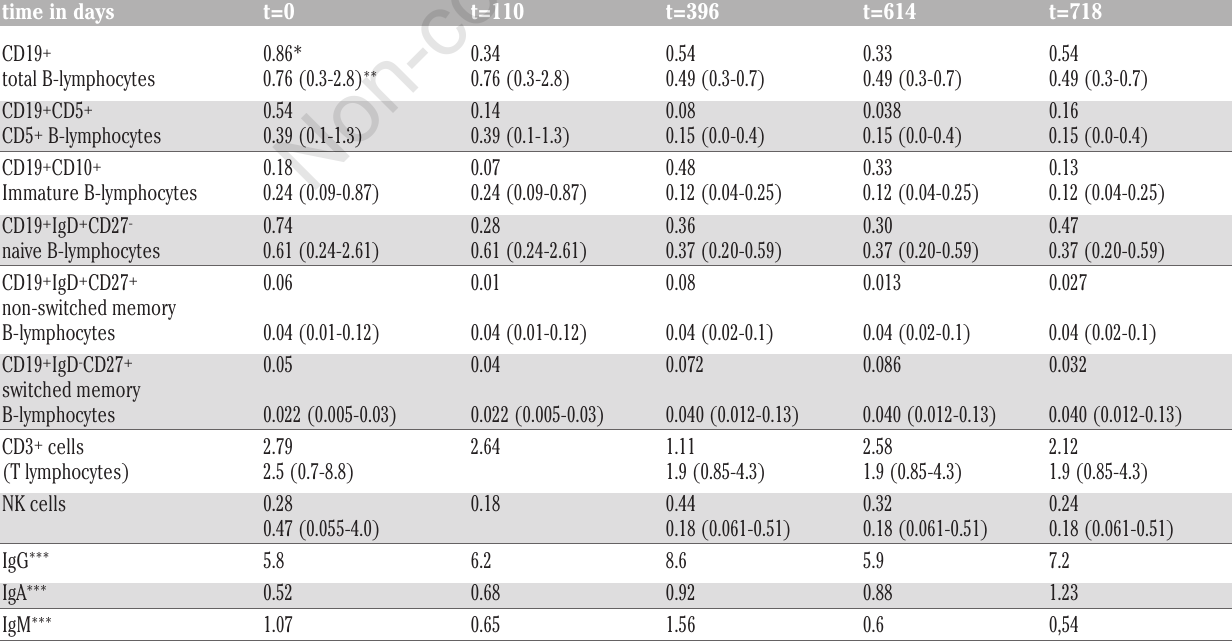
Table 1. Absolute values of lymphocyte subpopulations in comparison with control values from healthy age-matched children. time in